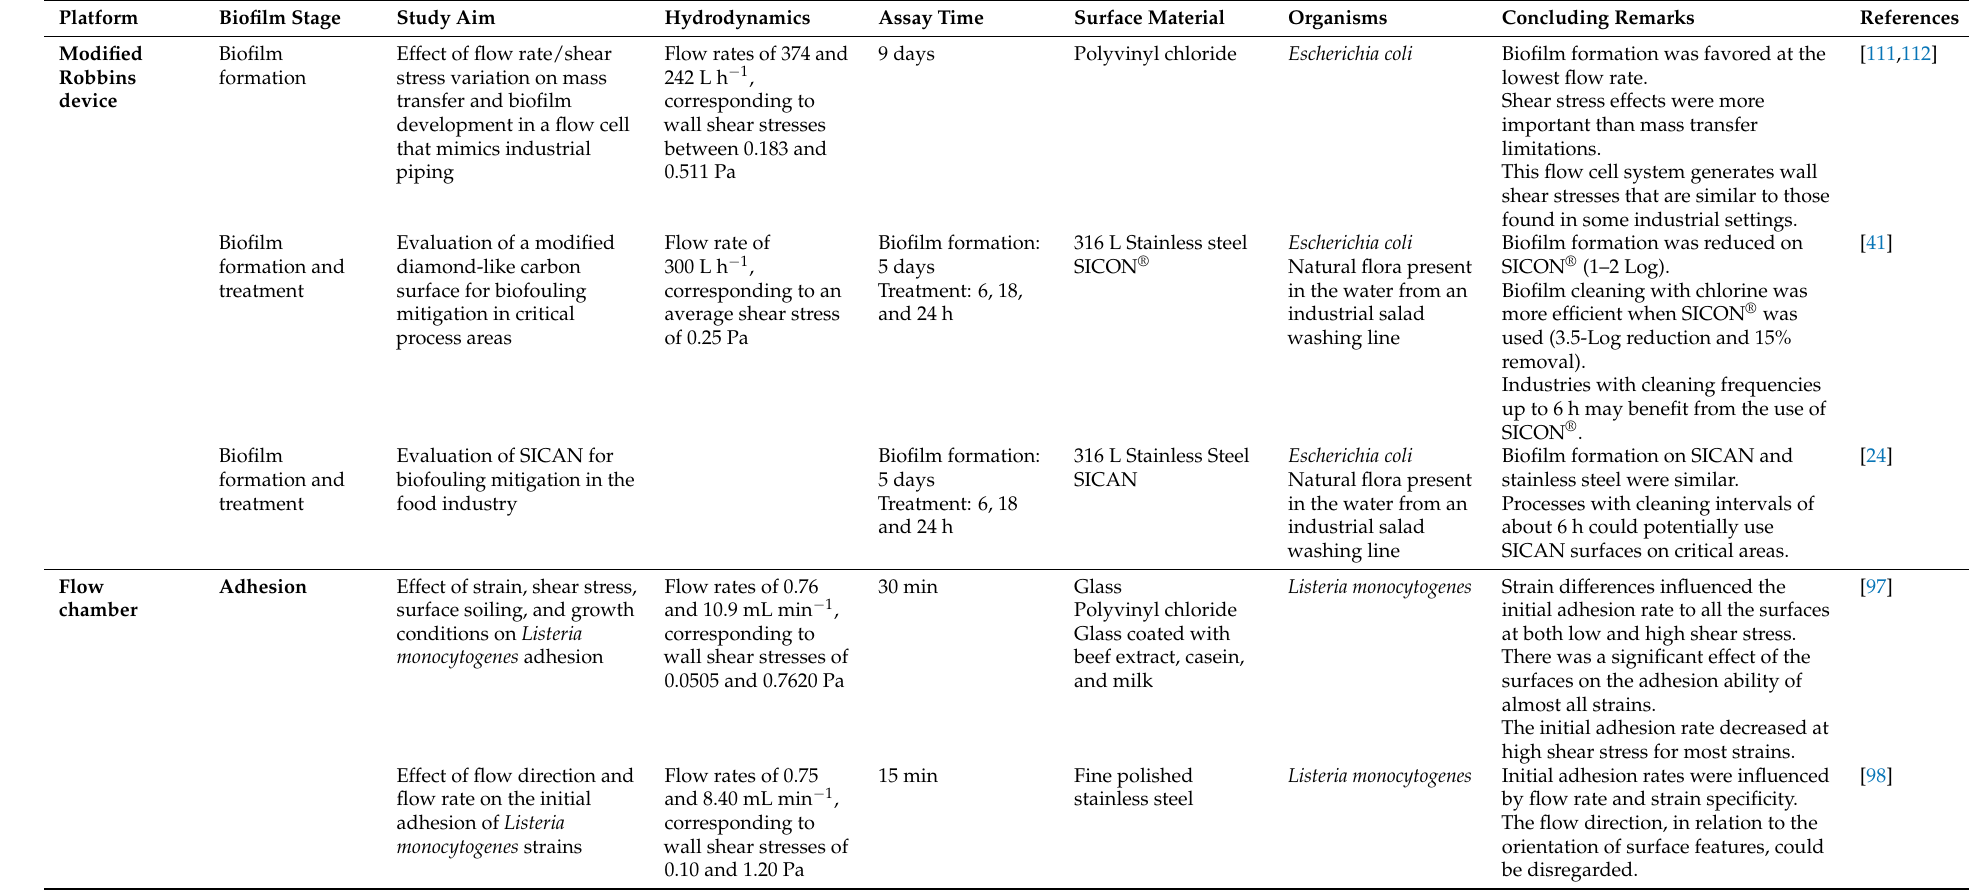
Table 5. Industrial studies performed on different biofilm platforms to evaluate the initial adhesion, as well as biofilm formation and treatment under defined shear conditions.